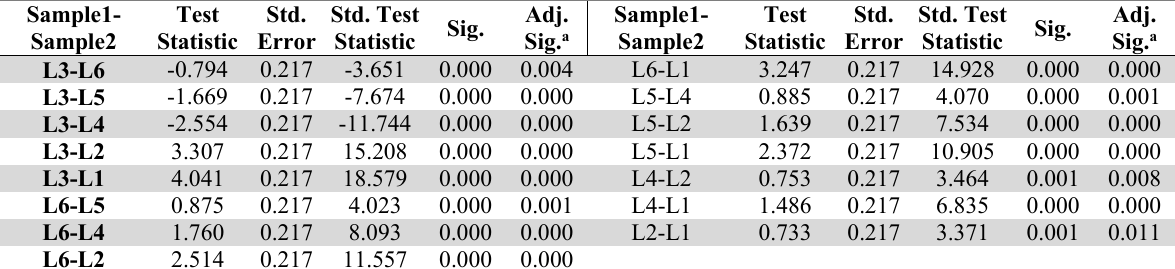
Bonferroni Dunn’s post hoc- Level of preference towards the outage mitigation methods